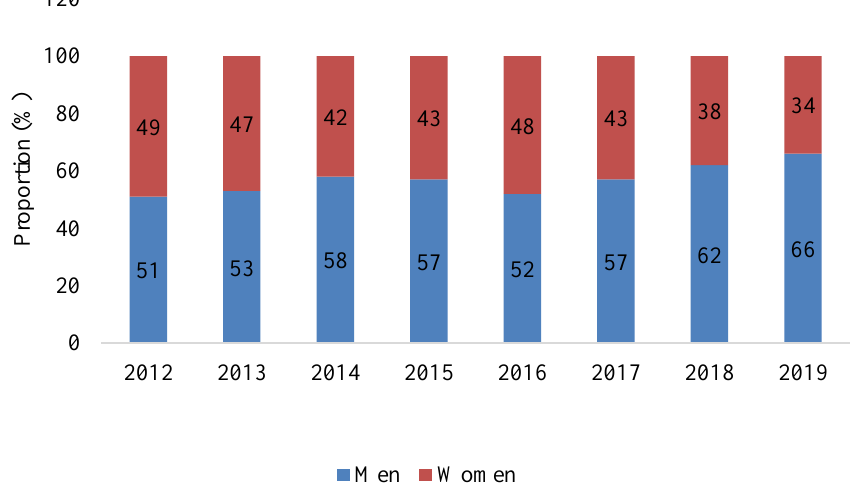
Fig. 4. Results of structural (gender) analysis of LGM patients (2012–2018 according to NCR and 2019 – results of forecasting relevant